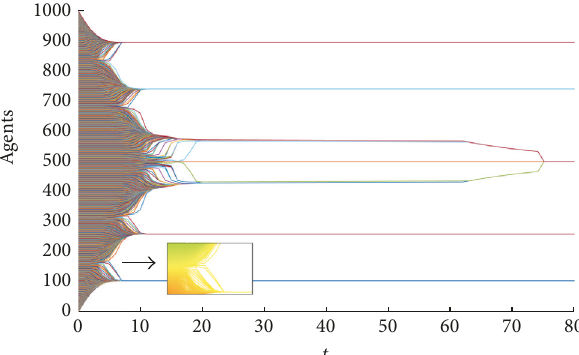
Figure 2: The number of agents 𝑛 determines the whole opinion profile in the random distribution of opinions in the network.